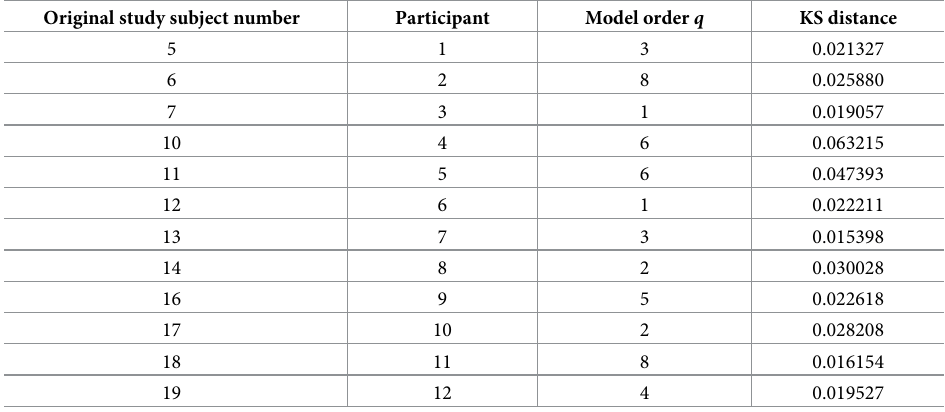
Table 1. Model parameter selection for heart